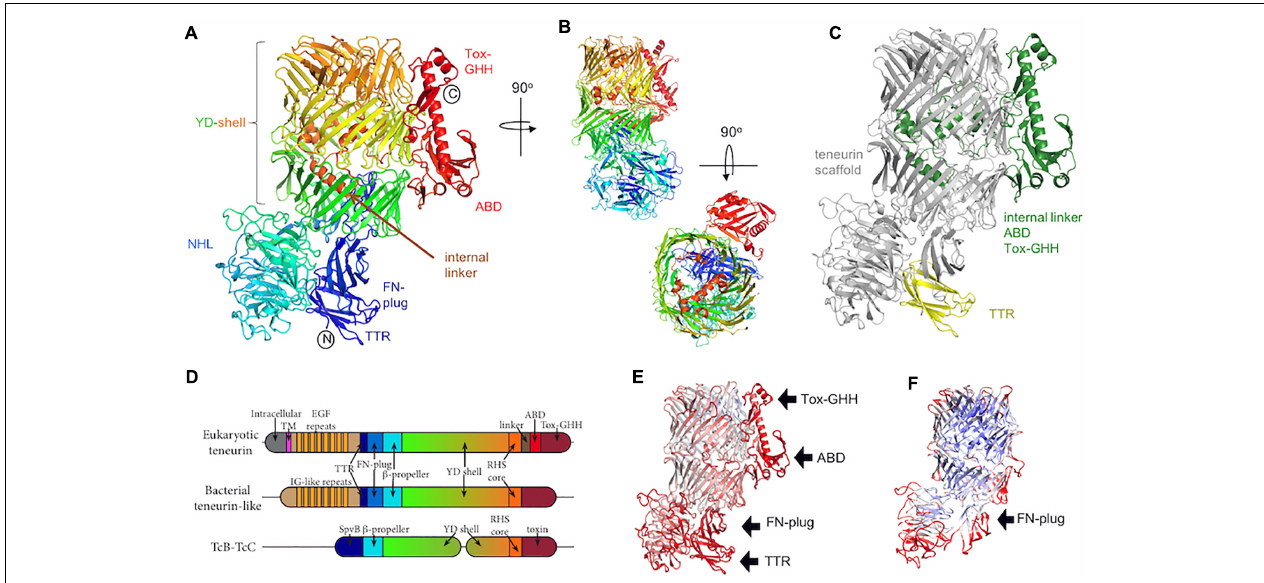
FIGURE 1 | The teneurin C-terminal region. (A) The crystal structure of chicken Ten2 (PDB 6FB3) is colored according to the rainbow (blue, N-terminus; red, C-terminus). The position of each subdomain is indicated. (B) Alternative views of the chicken Ten2 crystal structure with the NHL domain facing (upper) and a top view (lower). (C) Chicken Ten2 is shown with the teneurin scaffold in gray, upstream transthyretin-like (TTR) domain in yellow, and downstream linker, antibiotic-binding-like domain (ABD) and Tox-GHH domains in green. (D) Schematic of the subdomains found in vertebrate teneurins, a bacterial teneurin-like protein from Bacillus subtilis (WP_088111228.1), and TcB/TcC toxins. (E) The model of chicken Ten2 (chain D) is colored according to the temperature factor (B-factors), from low (min = 30 Å 2 , blue) to high (max = 150 Å 2 , red). The black arrows point out the least rigidly ordered areas of the crystal structure, which have the